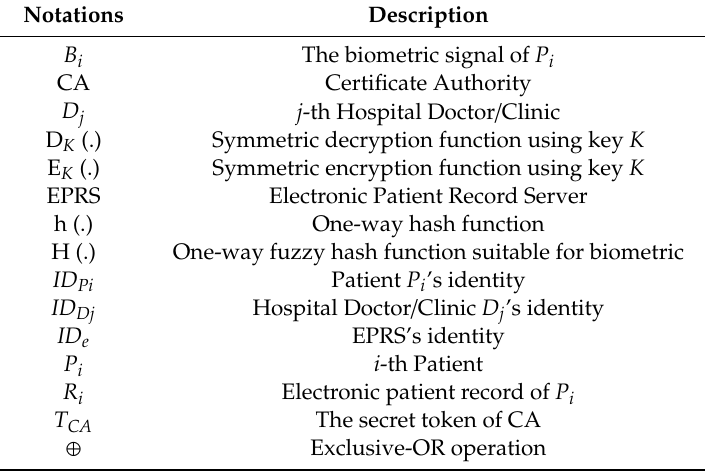
Table 1. Notations